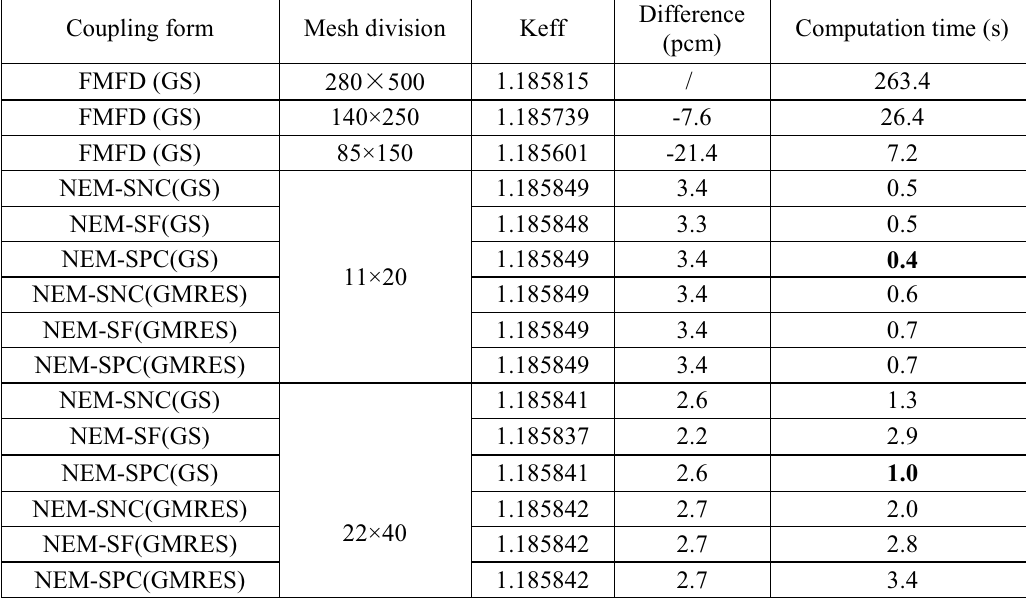
Table I. Calculation results of case 1 (without cavity)